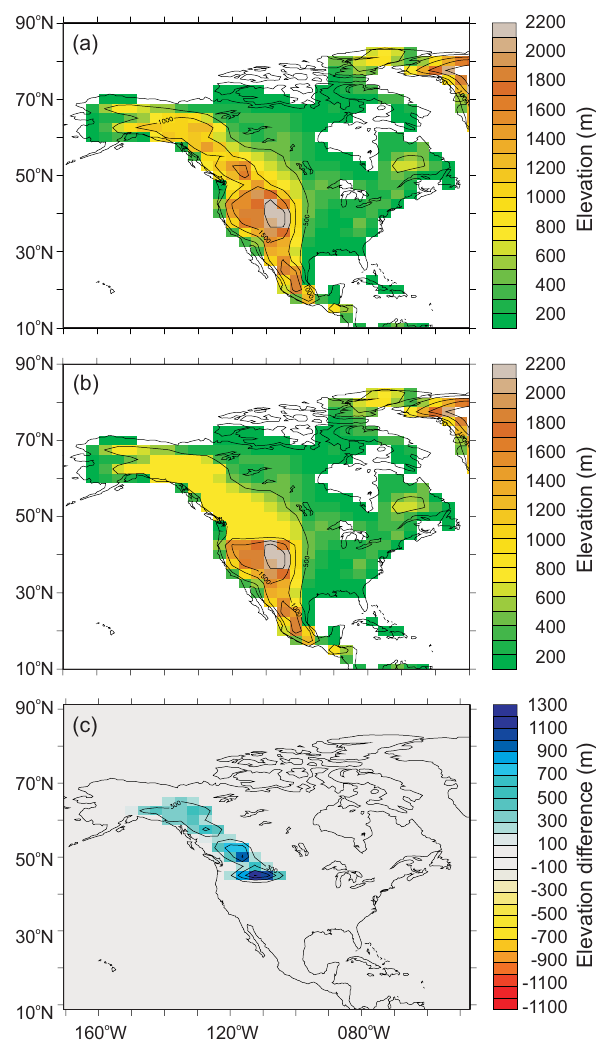
Fig. 3. Topographic boundary conditions of North America. (a) modern configuration used for the pre-industrial control; (b) “low- 45N” configuration; (c) anomaly plot for “low-45N” plot (modern –